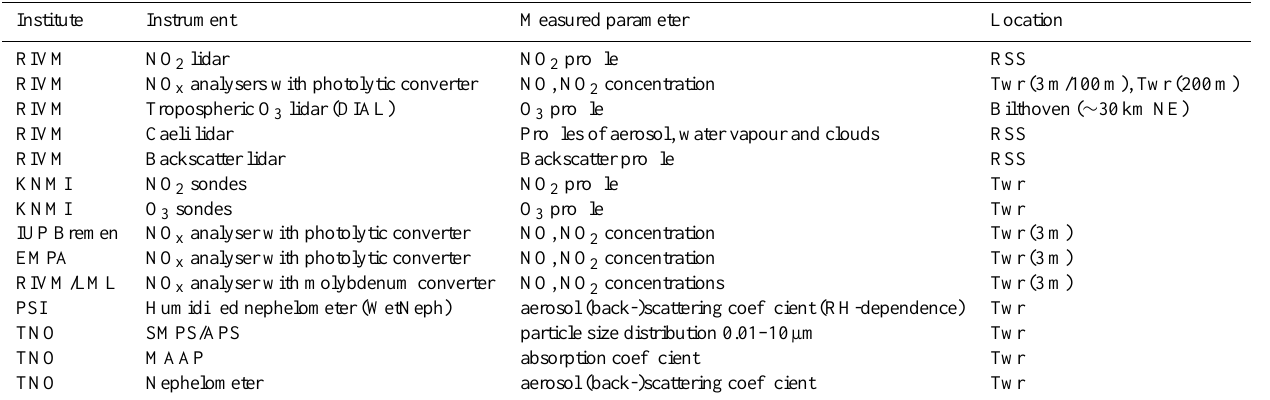
Table 2. Other CINDI participating instruments, measuring NO 2 , ozone, and aerosol. Site locations are RSS: remote sensing site, Twr: tower, WP: wind profiler site. Other details are given in Appendix A.